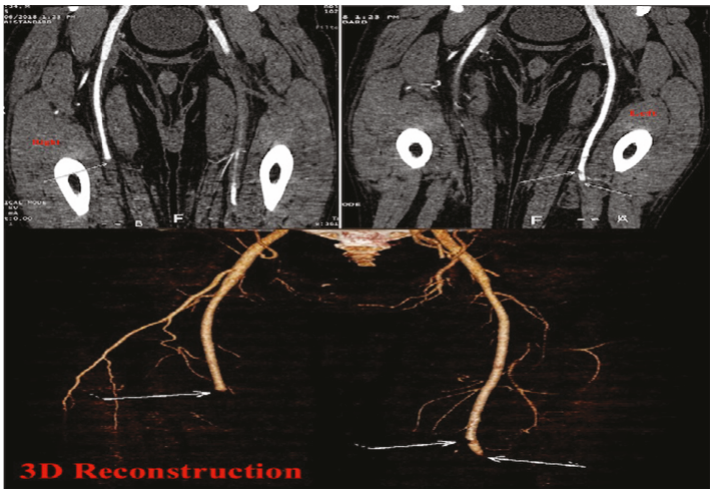
Figure 3: A computed tomography angiogram of bilateral lower extremity: severe occlusive bilateral super fi cial femoral arteries at the level of the mid thighs and occlusion of the right internal iliac artery. Mild reconstitution is seen on the right side anterior tibial artery with no fl ow in it seen distal to the ankle. No reconstitution is seen on the left side. No radiographic evidence of collateralization.